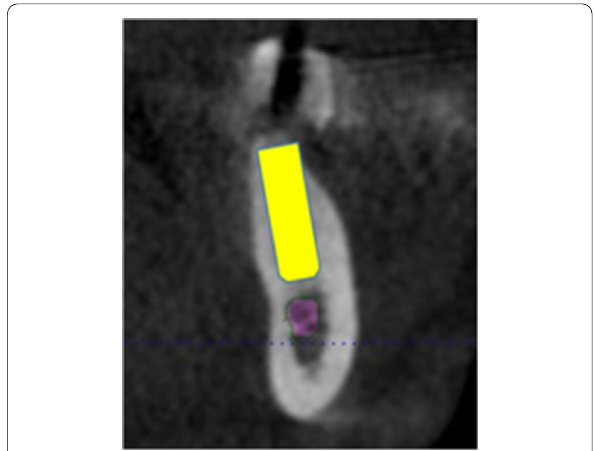
Fig. 2 The same patient’s (Fig. 1) CBCT with the virtually planned implant in region 37 showed inconspicuous jaw